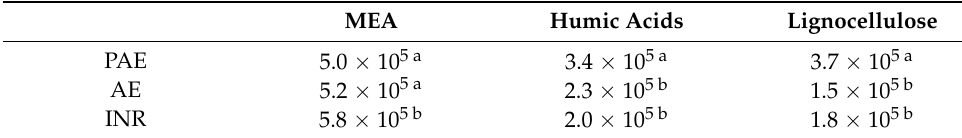
Table 3. Evaluation of total fungal counts (CFU) per gram of dry soil from the Polluted AgroEcosystem (PAE), AgroEcosystem (AE), and the integral natural reserve (INR) plated on MEA, humic acids, and lignocellulose. Values with different letters in the same column are significantly different ( p < 0.05, ANOVA